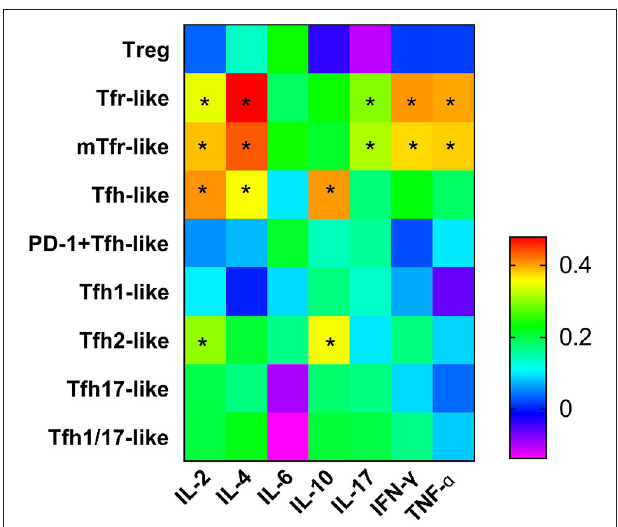
FIGURE 5 | Heat map from correlation analysis between serum cytokines and Tfr-like and Tfh-like cells and their subsets. Correlations were assessed using Spearman’s rank test. * p < 0.05. A total of 10,000 Tfh-like cells were collected. Tfr-like, T follicular regulatory-like; mTfr-like, memory T